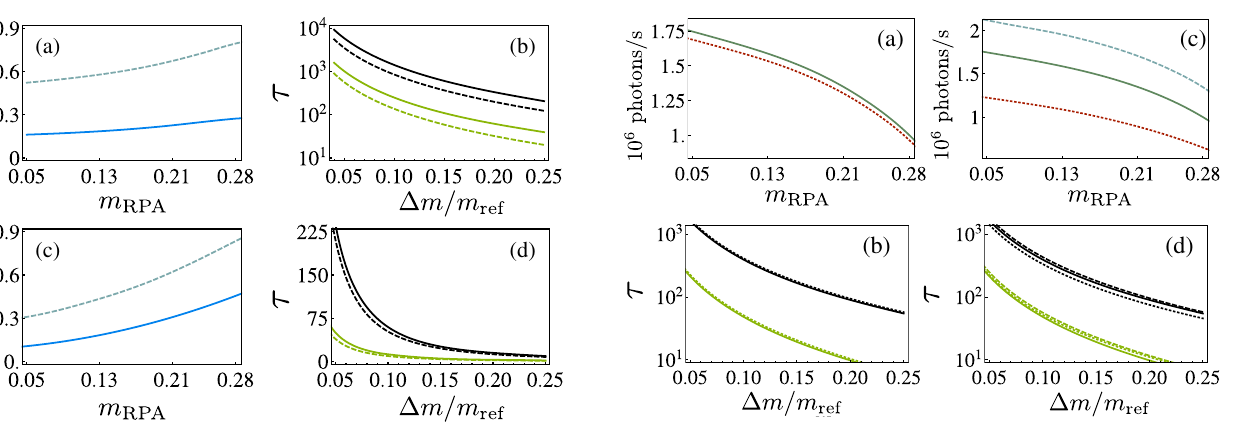
FIG. 18. T ¼ 0 collected photon rates vs the RPA corrected FIG. 17. Measurement accuracy at κ ¼ 1 . 5 when light along the AFM-order parameter m with a lens of NA ¼ 0 . 8 in the direction of the emerging magnetic Bragg peak is detected. The RPA forward direction (top row) and the corresponding estimated calculations are based on RPA susceptibilities at T ¼ 0 with an number of experimental realizations to achieve a relative accu- RPA corrected order parameter m for the elastic component. RPA racy Δ m=m (bottom row). The calculations are computed with We show the collected photon rates vs the RPA corrected AFM- ref RPA susceptibilities at T ¼ 0 and with an RPA corrected order order parameter m (left column) and the number of exper- RPA parameter m for the elastic component. In both (a) and (b), we imental realizations τ to achieve a relative accuracy Δ m=m RPA ref show a fixed value of κ ¼ 1 . 05 and compare two different lattice (right column). In all the plots (a) – (d), dashed curves correspond depths s ¼ 7 . 8 (dotted line) and s ¼ 25 (solid line). In (b), the top to the configuration of a lens with NA ¼ 0 . 4 pointing in the ≃ 0 . 12 , and the bottom two two curves (in black) are for m perpendicular direction [Fig. 16(c)], and solid curves are for a ref ≃ 0 . 19 . The top two curves are curves (in green) are for m small lens with NA ¼ 0 . 2 pointing in the direction of the ref essentially on top of one another, similarly for the bottom two emerging magnetic Bragg peak [Fig. 16(a)]. Note that the lens curves. In both (c) and (d), we show a fixed lattice depth s ¼ 25 in the perpendicular direction also collects the signal from two and compare three different values of the parameter κ ¼ 0 . 66 magnetic Bragg peaks. Plots (a) and (b) show the case when both (dotted line), κ ¼ 1 . 05 (solid line), and κ ¼ 1 . 5 (dashed line). spin species are detected. Plots (c) and (d) show the case when Note that varying κ changes the width of the elastic diffraction only the j ↓ i atoms are detected. Far fewer experimental realiza- peak. Thus, to block out the main elastic diffraction peaks, a tions are needed for a given accuracy when only one species is different block width is required for each κ value (see Table I). detected. In plots (b) and (d), we show the τ values for two ≃ 0 . 12 , and ≃ 0 . 12 in black (top two curves) In (d), the top three curves (in black) are for m different reference states: m ref ref ≃ 0 . 19 . The top ≃ 0 . 19 in green (bottom two curves). the bottom three curves (in green) are for m and m ref ref three curves are close together, and even more so for the bottom three